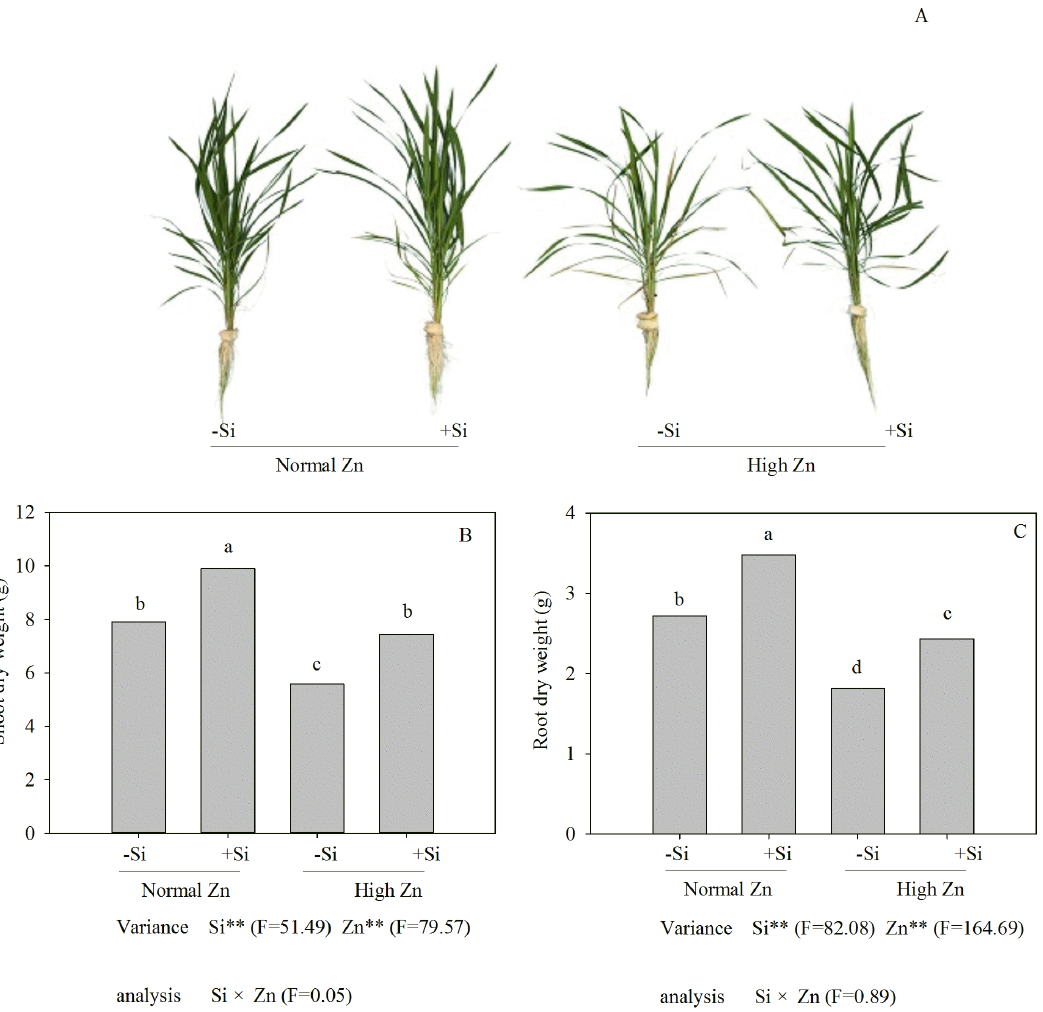
Figure 2. Zn toxicity symptoms (A), shoot (B) and root (C) dry weight of Zn-sensitive rice ( Oryza sativa L.) cultivar grown hydroponically with either normal (0.15 m M) or high (2 mM) Zn without or with 1.5 mM Si for seven days. Data are means ¡ S.D. of three replicates. Note: P-values indicate significance level based on two-way ANOVA. * P , 0.05, ** P , 0.01. Data followed by different letters are significantly different according to ANOVA (P ,